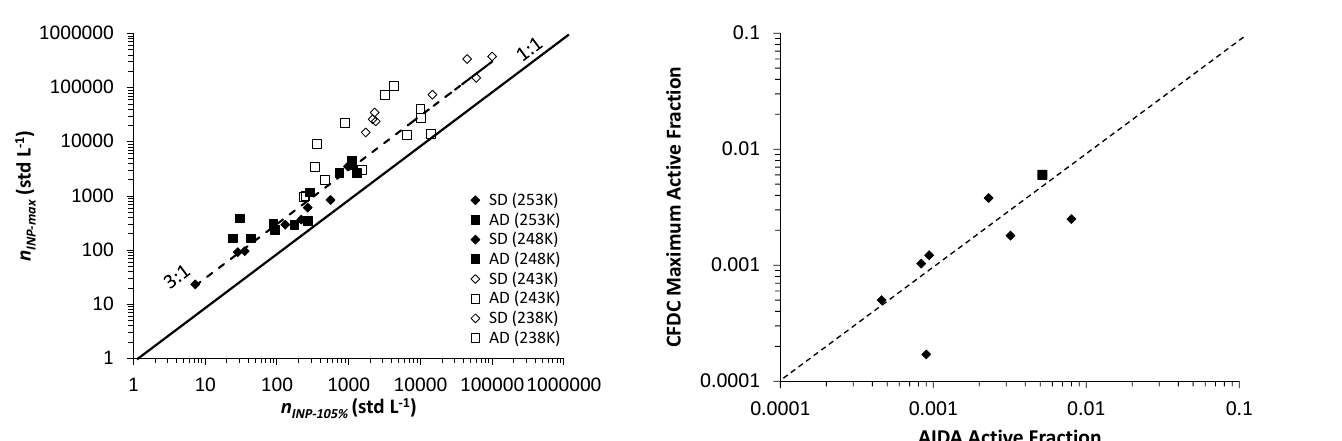
Figure 8. CFDC INP number concentration at peak RH w values (preceding droplet breakthrough) in comparison to n INP measured at 105% RH w . A range of temperatures from approximately 253 to 238K are represented, as shown. The dashed line expresses cf = 3 as a uniform correction on INP number concentration for this selection of data.